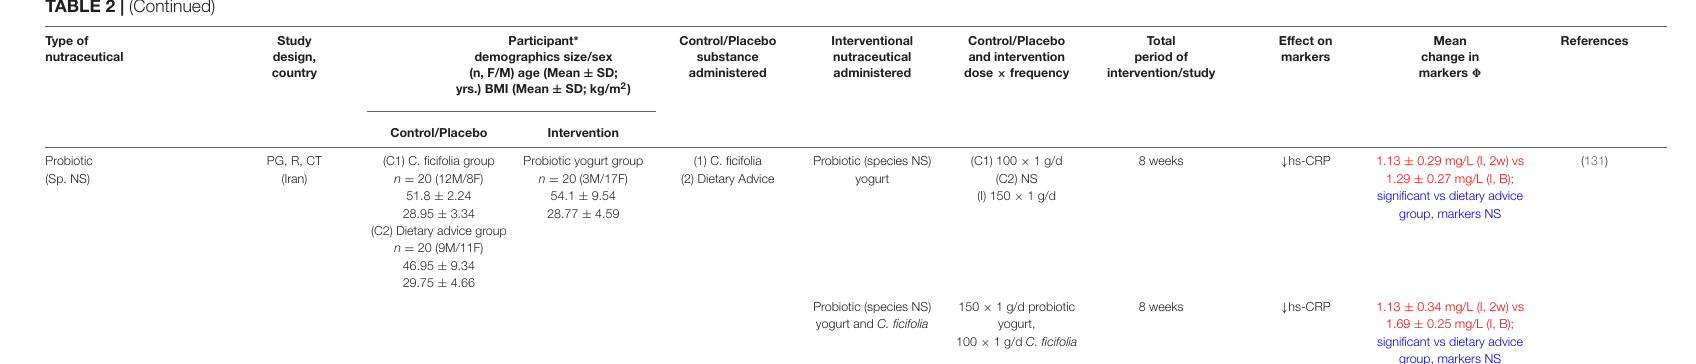
*All participants are T2D-diagnosed patients, unless otherwise stated; ↓ indicates a decrease in value; ↑ indicates an increase in value; . = No change in value; ↑ (x) = indicates prevention of increase in value compared to control; (cid:56) = Order of markers compared = those of Intervention (I) group first, Control (C) or baseline (B) second; Text color represents comparison body as follows, Blue = Comparison of effective change due to intervention by adjusted Mean Difference (MD) of changes in markers observed between I&C groups at end of the study from baseline; Green = Comparison of changes in I vs. C groups at the end of study from respective baselines; Red = Comparison of change (or difference) in markers at the end of study from baseline in I group; § = Non-significant Result; T2D = Type-2 Diabetes; NS = Not Specified; NR = Not Reported; Sp. = Species; SB = Single-Blinded; DB = Double-Blinded; R = Randomized; RCT = Randomized Controlled Trial; CC = Crossover Controlled; PC = Placebo-Controlled; PG = Parallel Group; CT = Clinical Trial;; OL = Open Label; MDA = Malondialdehyde; IL-6 = Interleukin 6; TNF- α = Tumor necrosis factor alpha; CRP = C-reactive protein; SCFA = Short-Chain Fatty Acid; NAFLD = Non- Alcoholic Fatty Liver Disease; GSH: Glutathione; GSSG = oxidized glutathione; Hs-CRP: High sensitivity C-Reactive Protein; CAT = Catalase; TAC = Total Antioxidant Capacity; TAS = Total Antioxidant Status; LPS = lipopolysaccharide; LBP = lipopolysaccharide binding protein; IL-1ra = IL-1 receptor antagonist; SOD = Superoxide Dismutase; GPX = Glutathione Peroxidase; GR = glutathione reductase; HP = High Performance;; F2-iso = F2-isoprostane; IFG = impaired fasting glucose; IGT = impaired glucose tolerance; NGT = normal glucose tolerance; IGT = impaired glucose tolerance; CHD = Coronary Heart